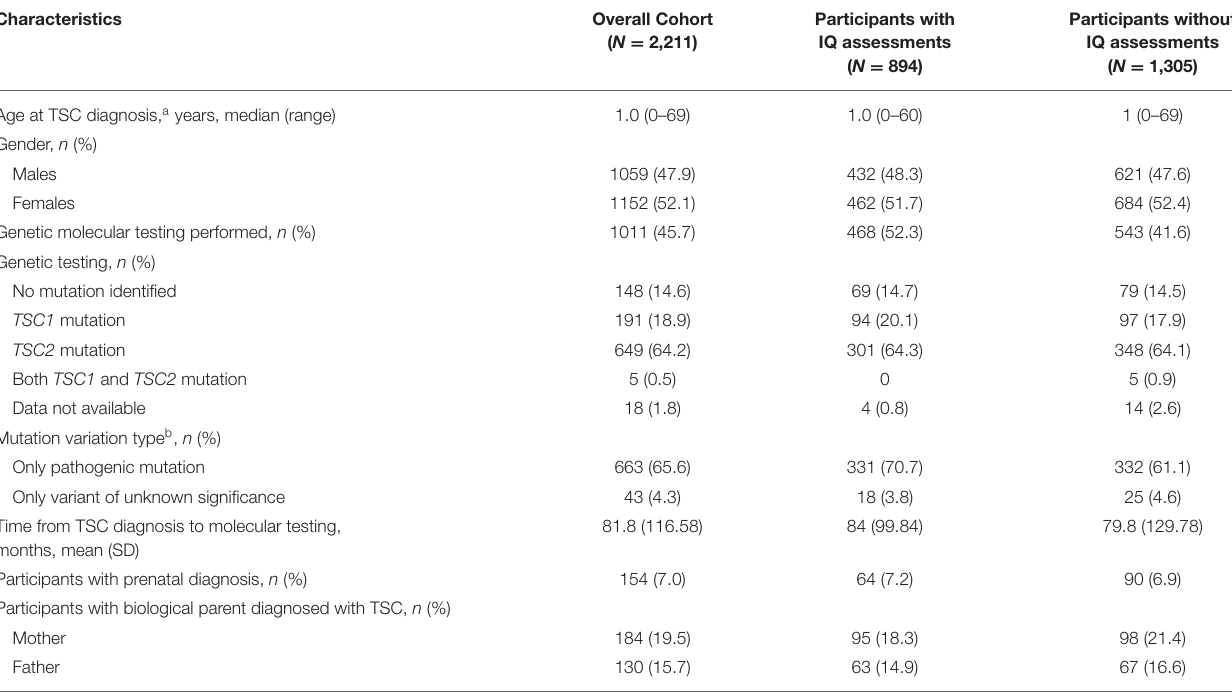
TABLE 1 | Demographics of participants in the TOSCA